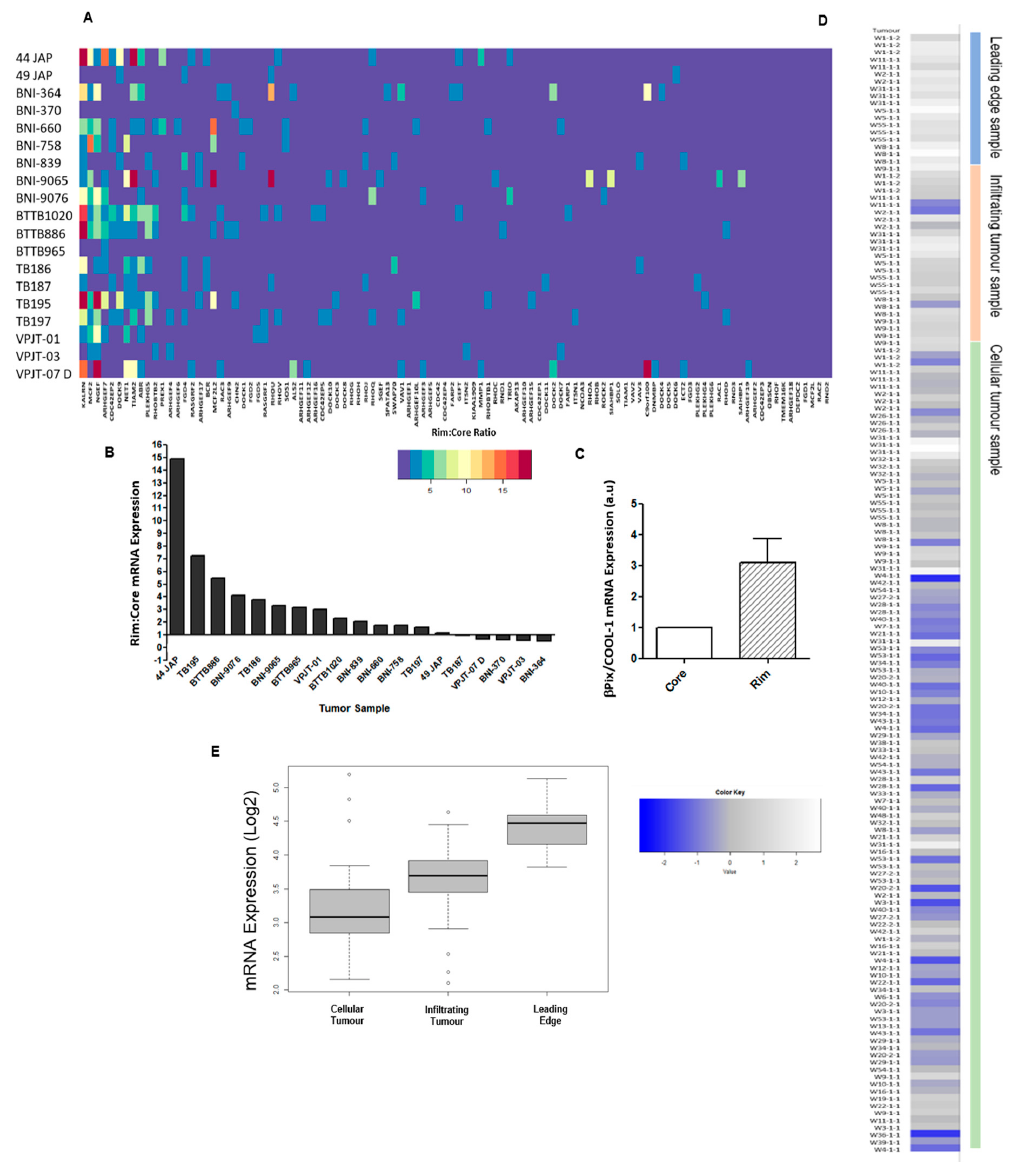
Figure 1. Rim:Core ratio analysis of tumours identifies β PIX/COOL-1 as being overexpressed in invasive GBM cells compared to tumour core. ( A ) Rim to Core mRNA expression ratio of all GEF family proteins in 19 tumour specimens; ( B ) From 19 independent GBM specimens, stationary (core) and invasive (rim) cells were assessed for relative β PIX/COOL-1/ARHGEF7 mRNA signal intensity, which was expressed as a ratio of rim to core (from NCBI Gene Expression Omnibus GSE12689); ( C ) Average Rim: Core β PIX mRNA expression across all tumour samples; ( D ) ARHGEF7/ β PIX/COOL-1 mRNA expression in leading edge, infiltrating tumour and cellular tumour core samples (defined by reference histology) across 42 tumour samples from the IvyGap database (GSE107559) ( E ) Boxplot illustrating β PIX/COOL-1/ARHGEF7 mRNA expression in leading edge, infiltrating tumour and cellular tumour core samples from GSE107559. Wilcoxon signed-rank test, p < 0.05 deemed significant. ARHGEF7/ β Pix/COOL-1 mRNA expression was next assessed within the Ivy Glioblastoma Atlas Project RNAseq dataset (IvyGap GSE107559 [34]; N = 41 patients) (Figure 1D,E). Here, β Pix/COOL-1 mRNA expression is significantly upregulated in samples derived from the leading